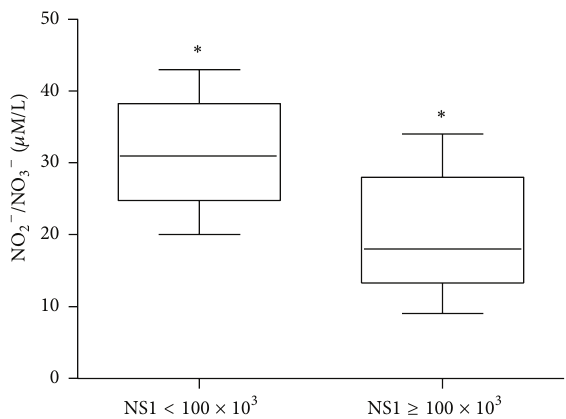
Figure4:Tumornecrosisfactoralpha(TNF- 𝛼 )production(pg/mL) by 1 × 10 6 peripheral blood mononuclear cells (PBMCs) from patients with dengue fever (DF, 𝑛 = 26 ) and dengue hemorrhagic fever (DHF, 𝑛 = 11 ) during the acute phase of the disease and healthy controls (HC, 𝑛 = 20 ). PBMCs were not stimulated (NS) or stimulated for 18 hours with 10 𝜇 g/mL of lipopolysaccharide (+ LPS) and TNF- 𝛼 production measured by ELISA. Results were expressed as median using a box plot. Equivalent symbols ( ∗ ) represent statistically significant differences ( 𝑃 < 0.05 ) between